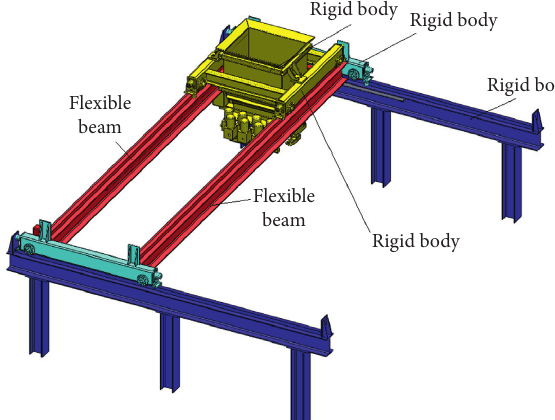
Figure 9: Rigid-flexible coupling model of the concrete